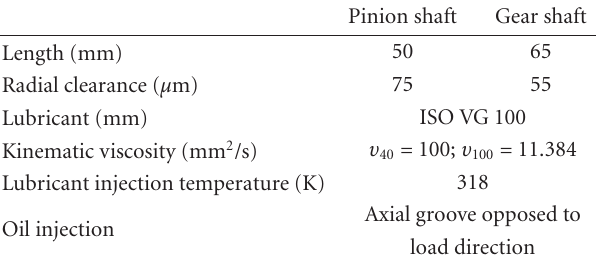
Table 3: Bearing (and lubricant)